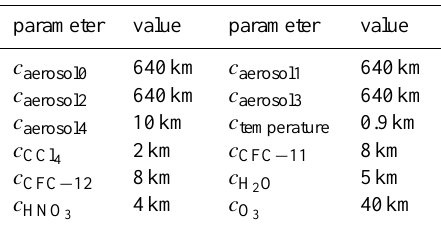
Table 3. Vertical correlation lengths employed for the regularisa-